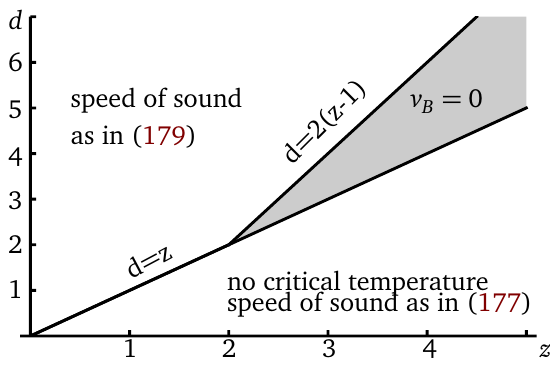
. There c = 0, and no B